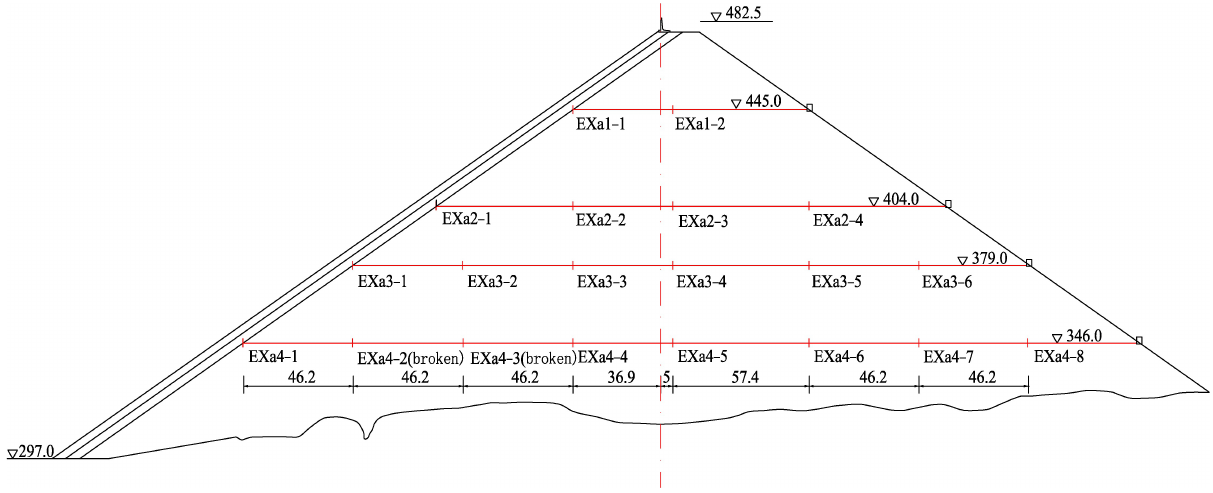
Figure 7. Layout of horizontal deformation measuring points.